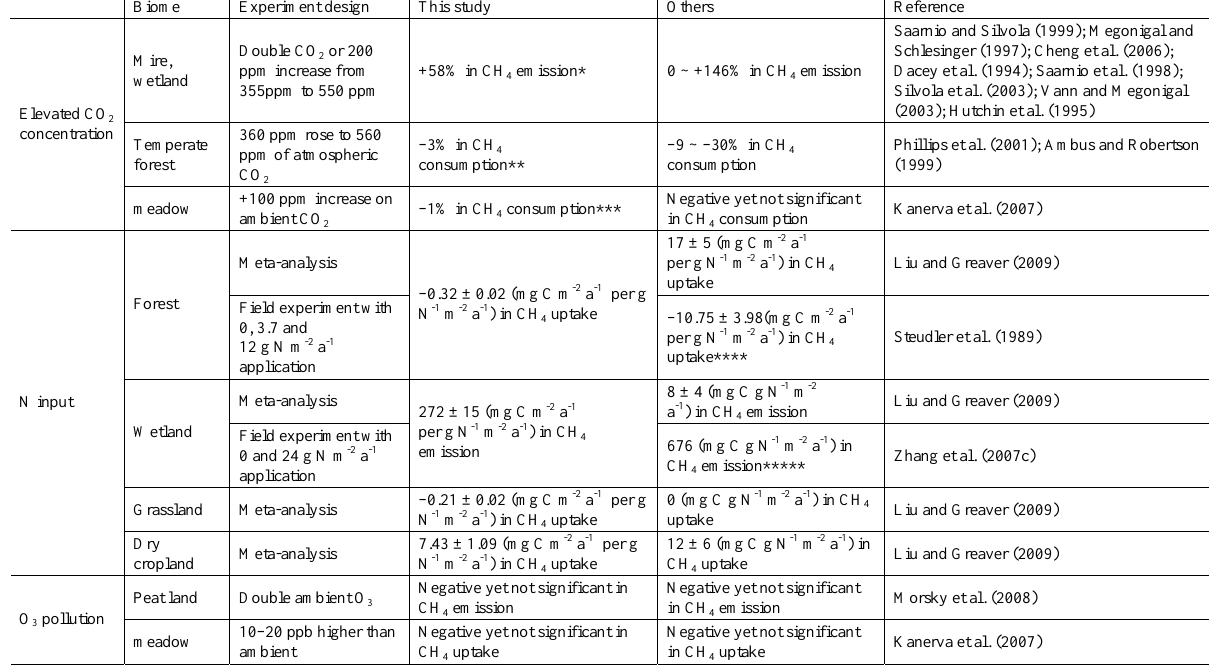
Table 6. Comparison of factorial effects on CH 4 fluxes against other studies (positive values mean increase, while negative values mean decrease, either in CH 4 uptake or in CH 4 emission). 2 Biome